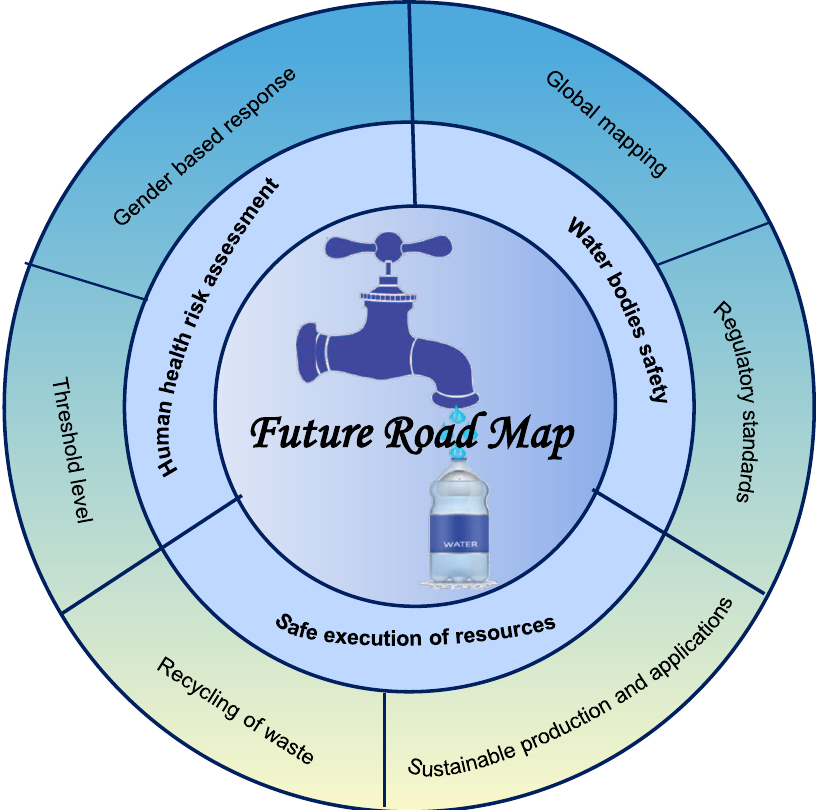
Fig. 6 Future framework and key concerns of Li in environmental